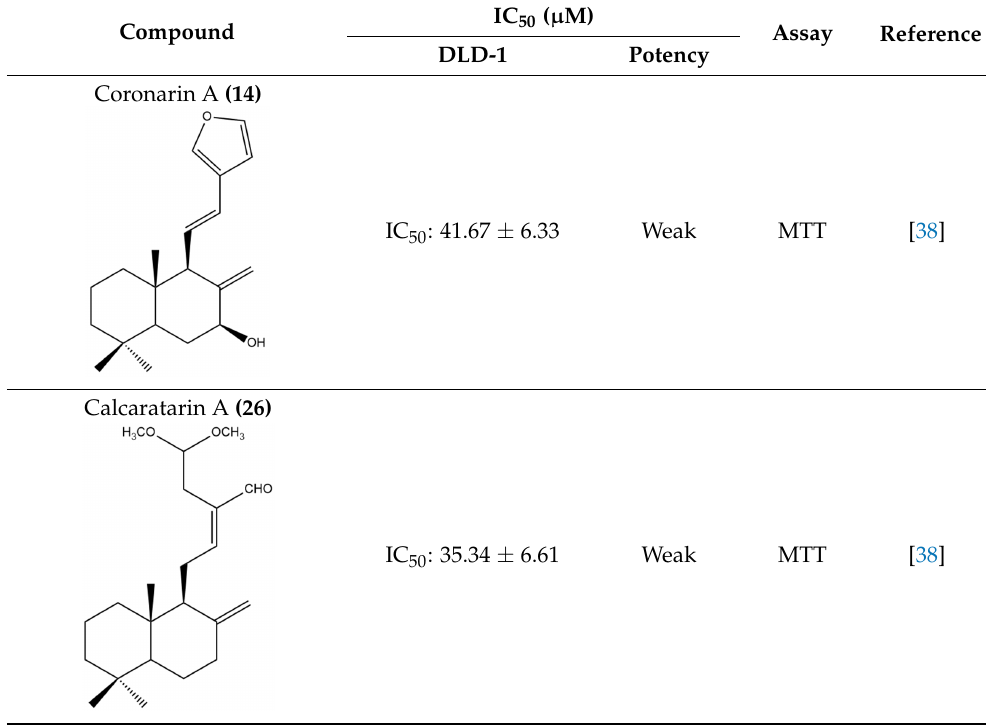
Table 16. Cytotoxic activities of labdane-type diterpenes from the Zingiberaceae against DLD-1 colorectal cancer cell line.